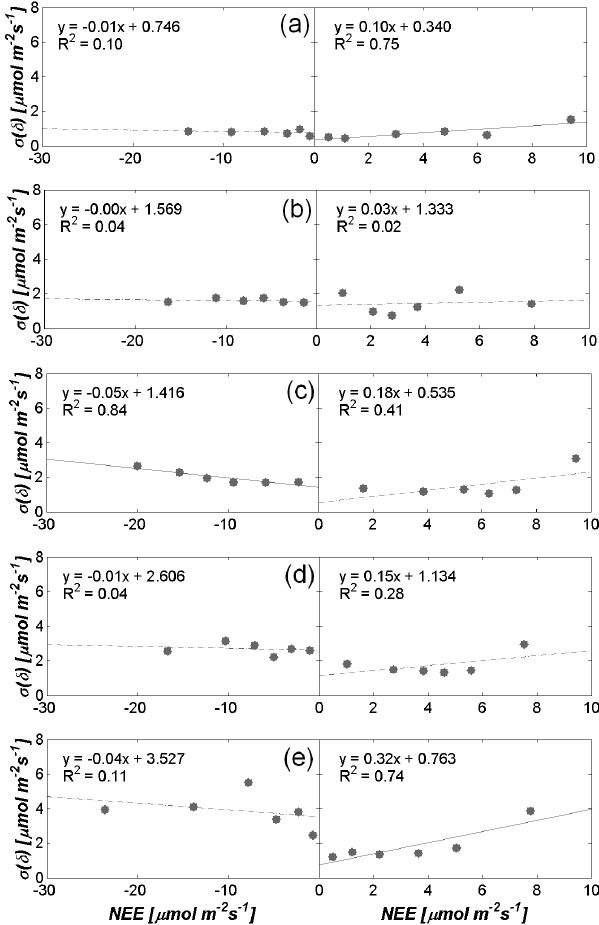
Figure 3. NEE uncertainty σ(δ) determined with the classical two- tower approach as function of the NEE flux magnitude including the application of the weather filter for the EC tower distances 8m (a) , 95m (b) , 173m (c) , 20.5km (d) and 34km (e) ; dashed line: linear correlation not significant ( p >